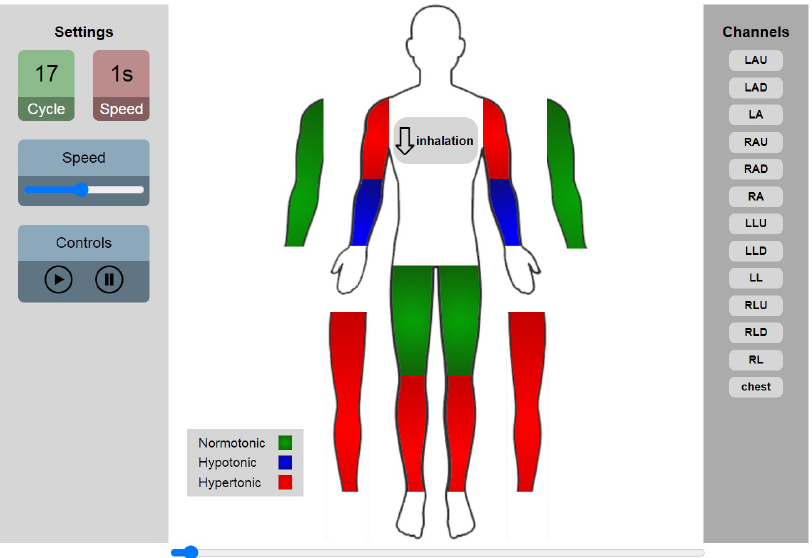
Figure 10. Vascular tone types and their distribution in the limbs for S1 cycle 17; red: hypertonic, blue: hypotonic, and green: